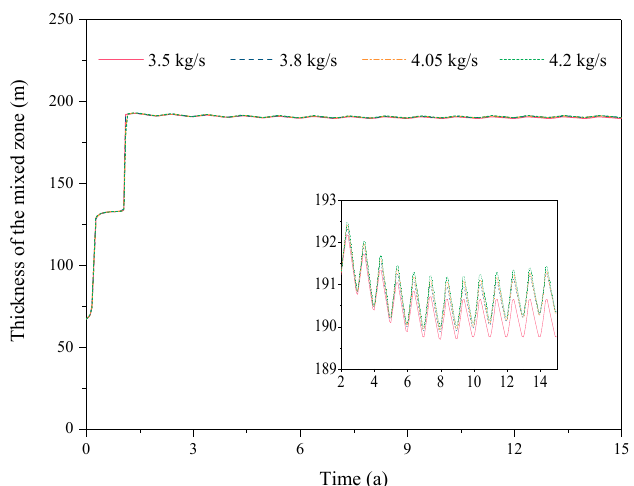
Figure 24. Reservoir average pressure for different production rates.